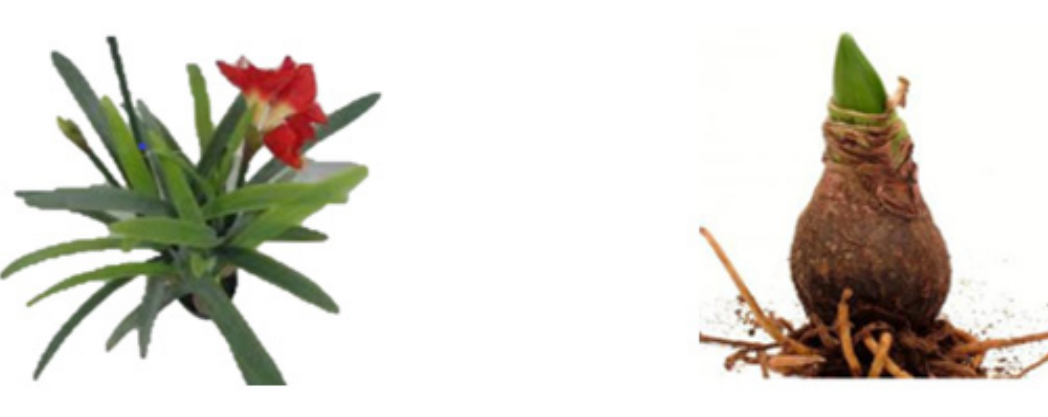
Figure 1. Leaf and Bulb of Amaryllis vittata (L.) Herit.